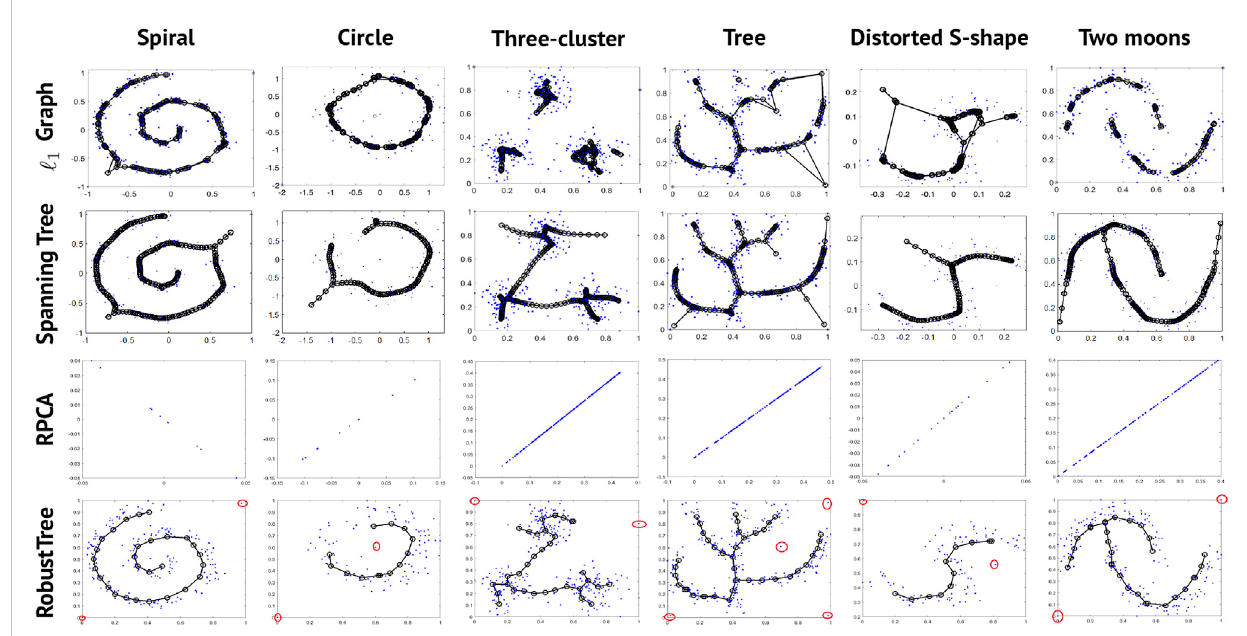
FIGURE 1 Resultsof4algorithmson6syntheticdatasetswithcontinuoustopologicalstructure.Theredcirclepointsinthefourthrowarethearti fi ciallyadded noise